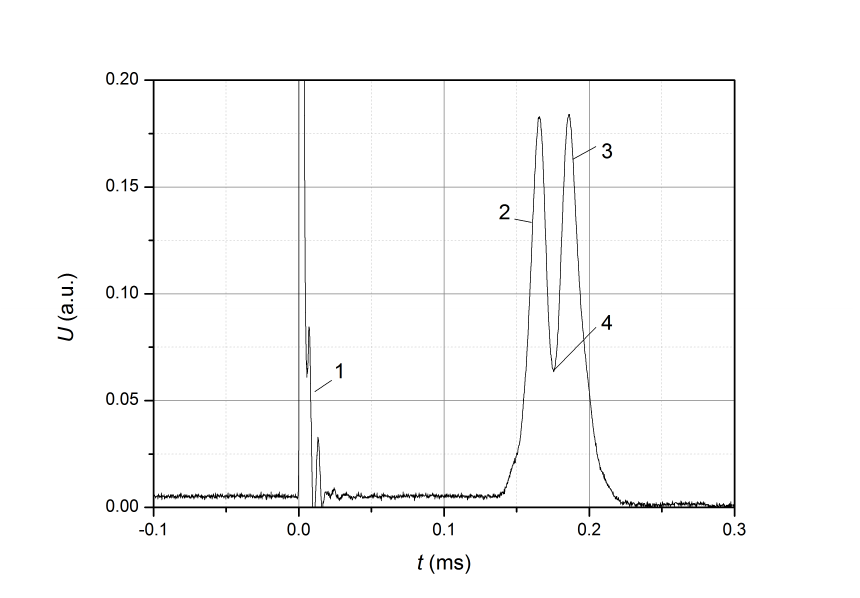
Figure 4. Waveform of the output signal: 1—induced interference caused by the current pulse; 2 and 3—pulses corresponding to the front and decay of the stretching wave; 4—the transition point from fiber stretching to